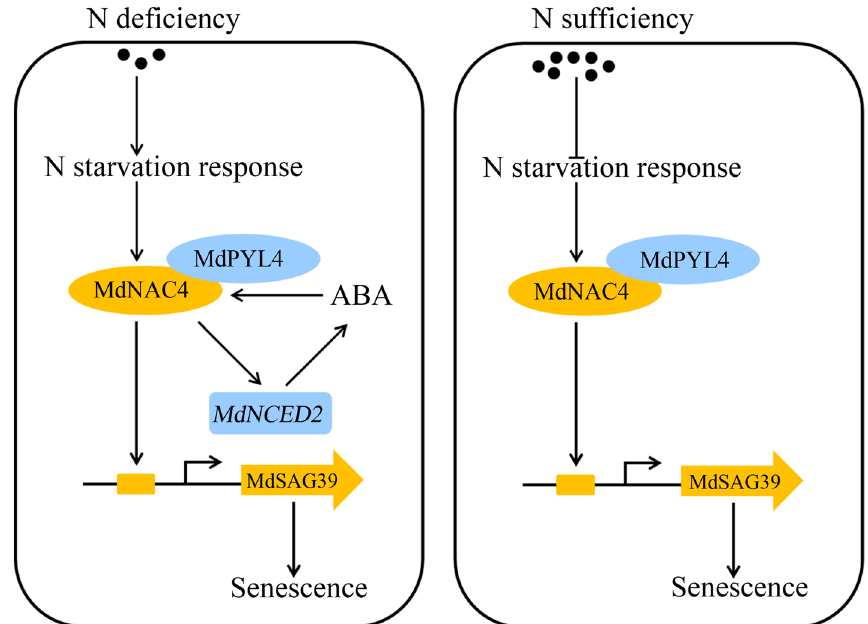
Fig. 10 A working model of the MdNAC4-mediated regulation of N deficiency-induced leaf senescence in apple. Under N-deficient conditions, N starvation-responsive genes are activated, which induces the expression of MdNAC4 . MdNAC4 directly activates the expression of the ABA biosynthesis gene MdNCED2 and further promotes ABA biosynthesis. The ABA receptor protein MdPYL4 interacts with the MdNAC4 protein and enhances the response of MdNAC4 to N deficiency. MdNAC4 directly binds to the SAG MdSAG39 and activates its expression, thus promoting leaf senescence induced by N deficiency. Under N-sufficient conditions, N starvation-responsive genes are suppressed. MdPYL4 interacts with MdNAC4 proteins to activate the expression of SAG MdSAG39 , thus regulating leaf